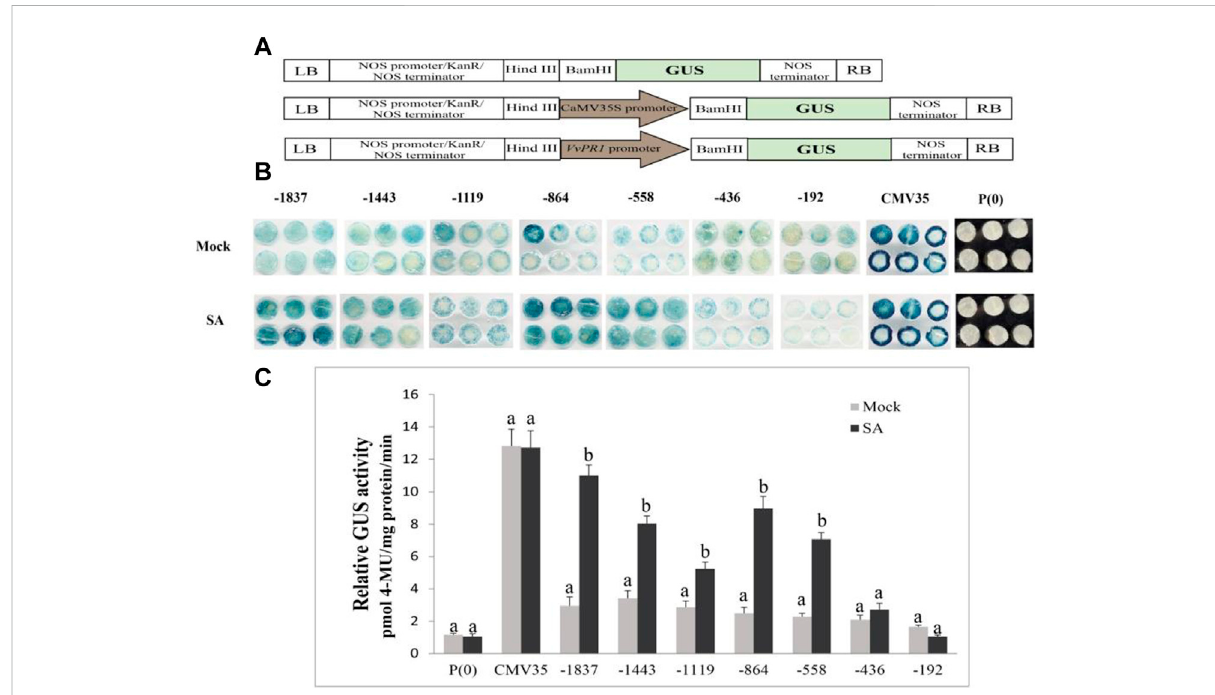
FIGURE 7 Schematicrepresentationforthevectorconstruction,histochemicalstaining,and fl uorometricassay. (A) Promoter-GUSexpressionconstructs showed the schematic structure. P(0); negative control; P(35S); positive control, and VvPR1 promoter in the forward orientation, respectively. (B) Histochemical staining analysis; GUS activity in transiently transformed N. benthamiana leaves with serially deleted VvPR1 promoter fragments ( − 1837, − 1,443, − 1,119, − 845, − 558, − 436, and − 192) bp against SA. (C) Fluorometric assay of VvPR1 promoter fragments ( − 1837, − 1,443, − 1,119, − 845, − 558, − 436,and − 192)bpinresponsetoSAintobaccoleavesthroughtransientexpression.Differentlettersonthebars showed a signi fi cant difference between SA-treated fragments and the control according to the least signi fi cant difference (LSD) test ( p <